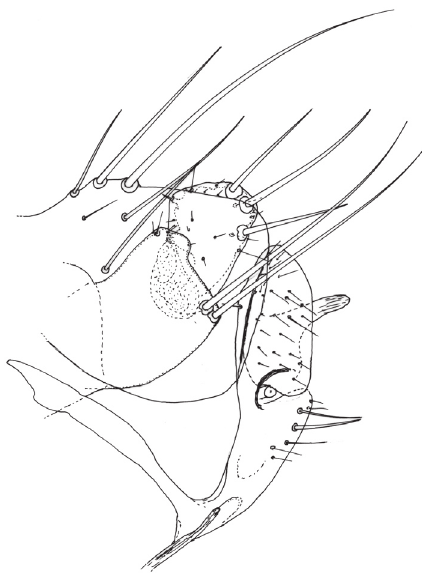
Figure 7. – Nosopsyllus (N.) incisus lewisi n. ssp. Tergite VIII et seg- ment IX du  holotype sur Aethomys sp., Nyika Plateau (Malawi), ca 2 220 m, 14 décembre 1963 (I.F. Keymer rec.